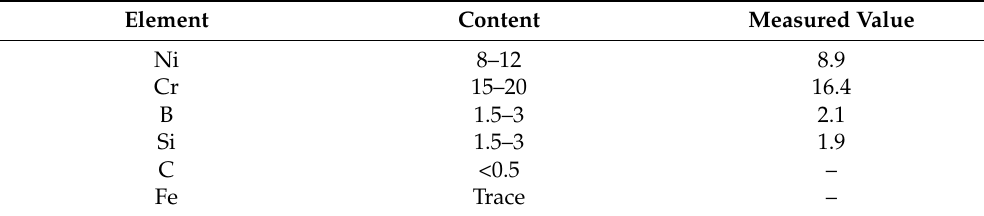
Table 1. Chemical composition of the Fe-based alloy powder Fe40 (wt %).